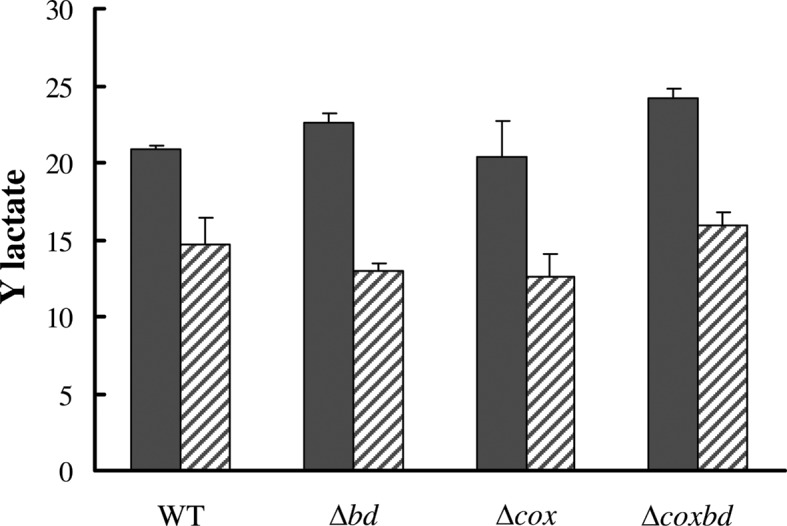
Molar growth yield for the four strains under various growth conditions.Molar growth yield on lactate for the wild-type and deletion mutant strains cultured under anaerobic conditions (black bars) and with constant 0.02% O2 gas mixture sparging (striped bars). Molar growth yields are expressed in 1012 cells/mole of substrate.